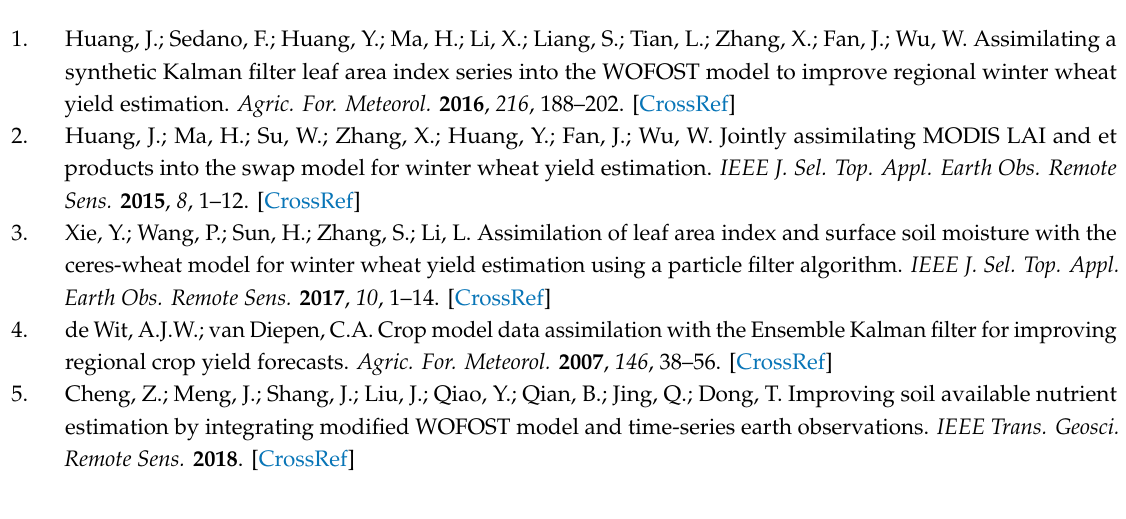
Table S1: Values of soil parameters for WOFOST model; Table S2. Values of crop parameters for WOFOST